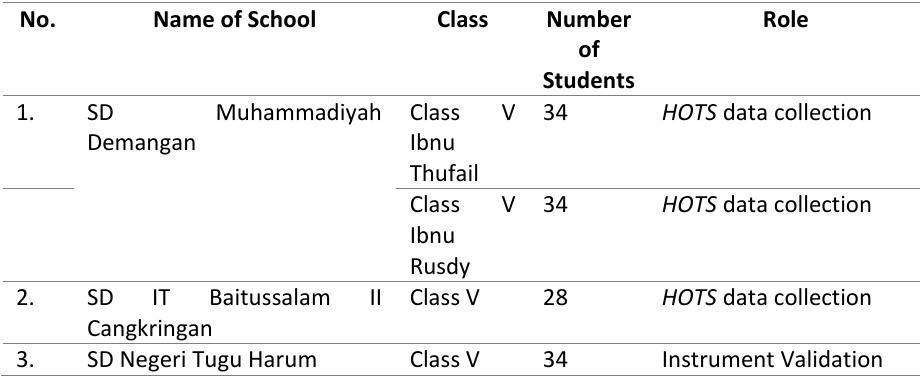
Table 1. Student